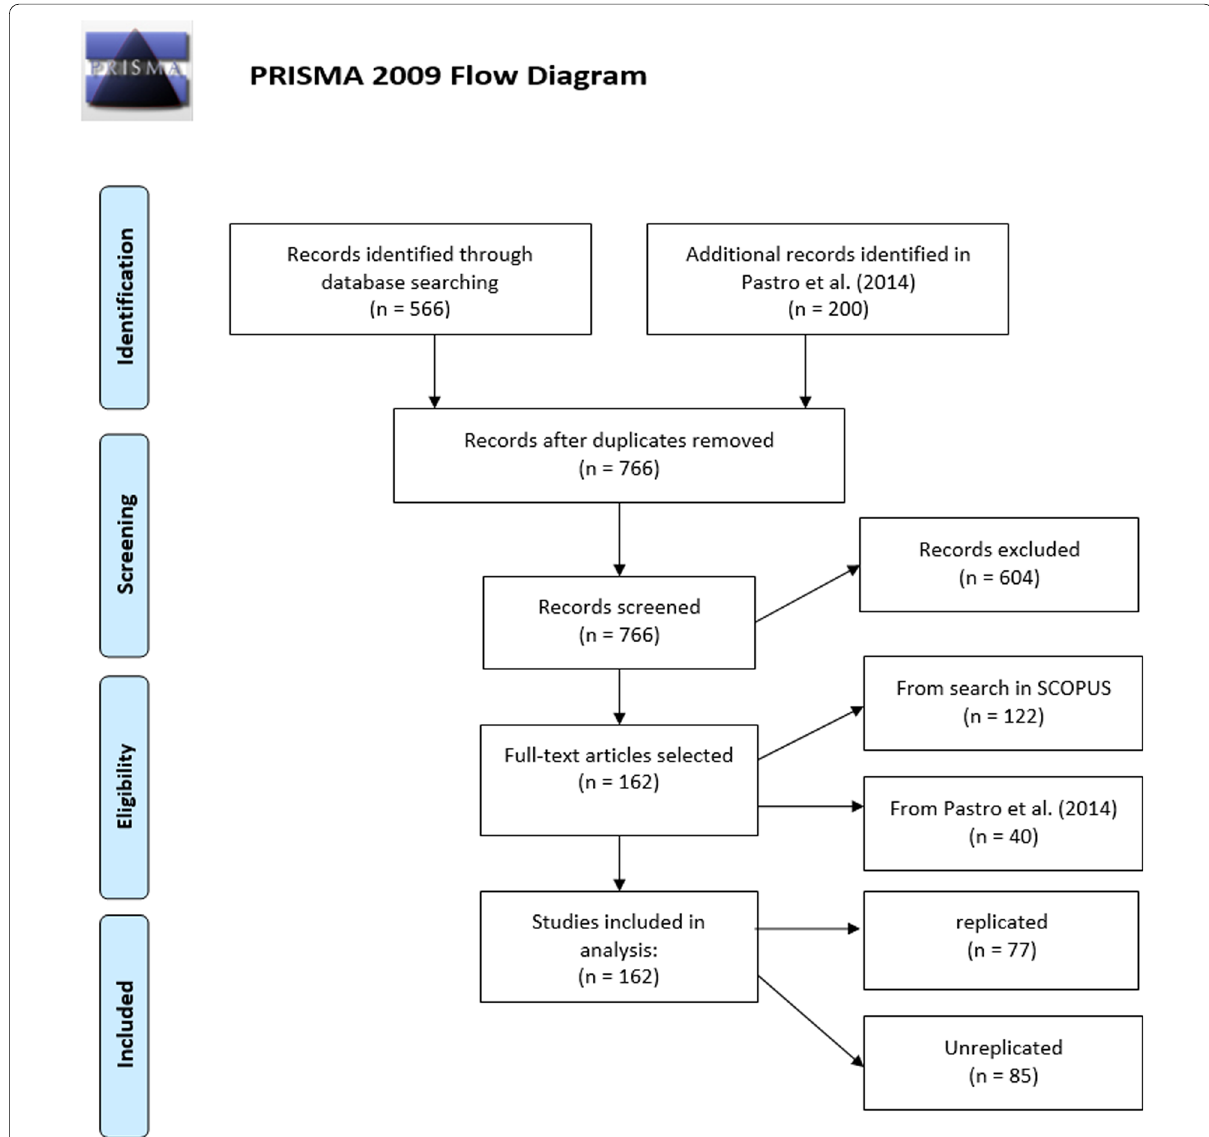
Fig. 1 PRISMA 2009 Flow Diagram from Moher et al.